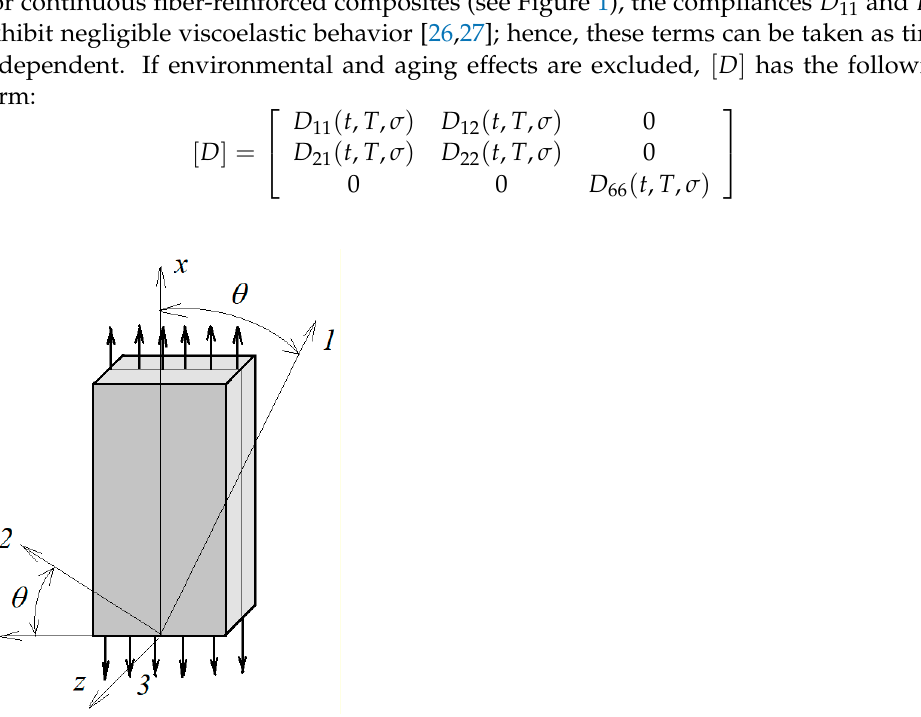
Figure 1. Anisotropic tensile specimen.